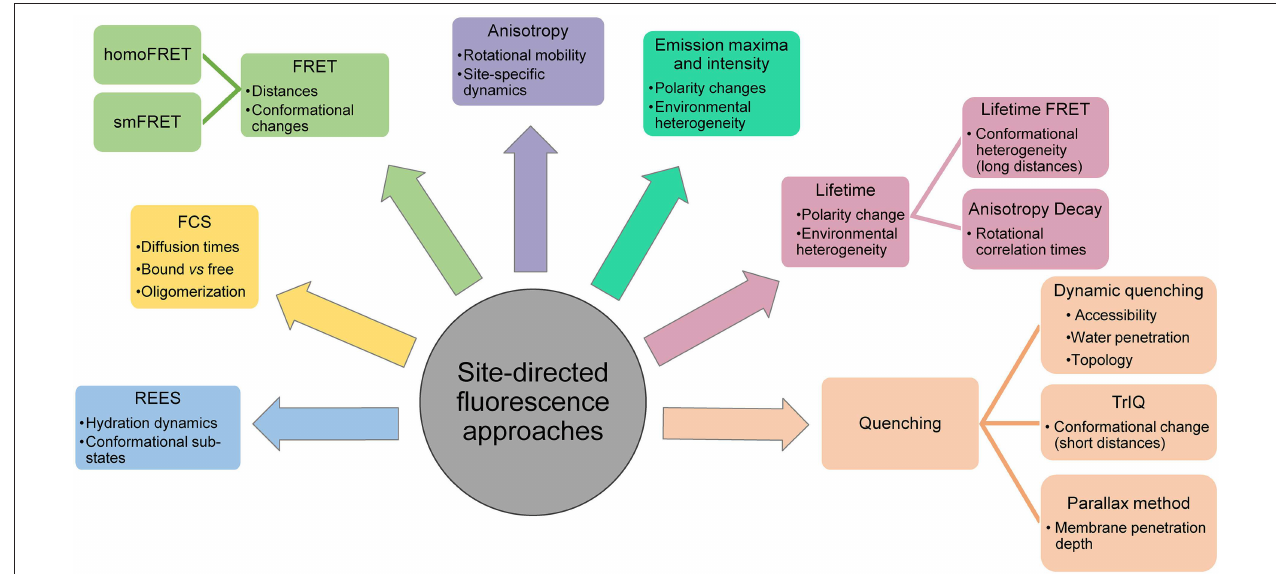
FIGURE 4 | Applications of site-directed fluorescence approaches used in dynamic structural biology of membrane